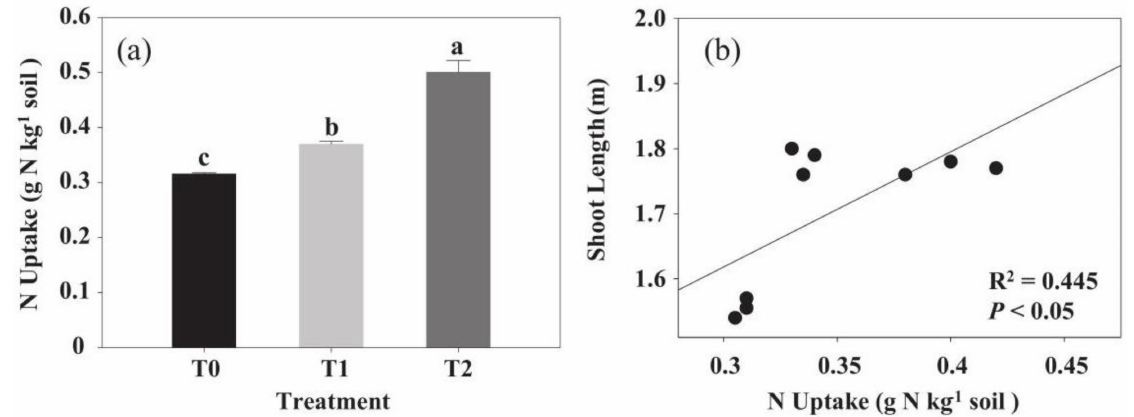
Figure 5. ( a ) Total N uptake under three different residue placement treatments (T0, none; T1, surface; T2, incorporated) and ( b ) the regression of shoot length and N uptake at the R3 stage in the pot experiment. Mean value ± standard error ( n = 4) is shown. Different lower-case letters indicate statistically significant differences at p <